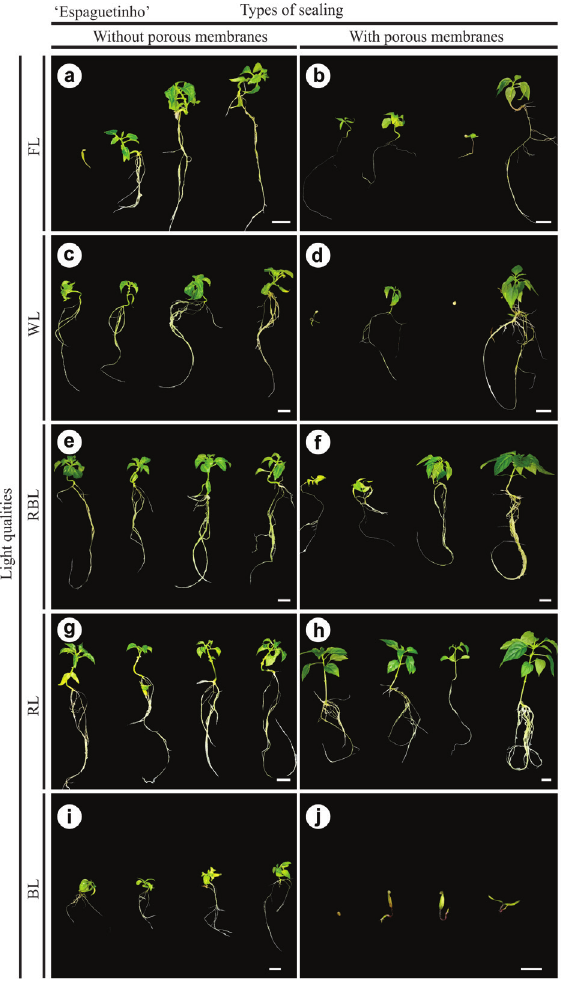
Figure 1. Plants of Capsicum frutescens cv. ‘Espaguetinho’ cultivated in vitro under different light qualities and types of sealing: Fluorescent (FL) without (a) and with porous membranes (b) ; White LED (WL) without (c) and with porous membranes (d) ; Red/blue LED (RBL) without (e) and with porous membranes (f) ; Blue LED (BL) without (g) and with porous membranes (h) ; Red LED (RL) without (i) and with porous membranes (j) . Bars: 1